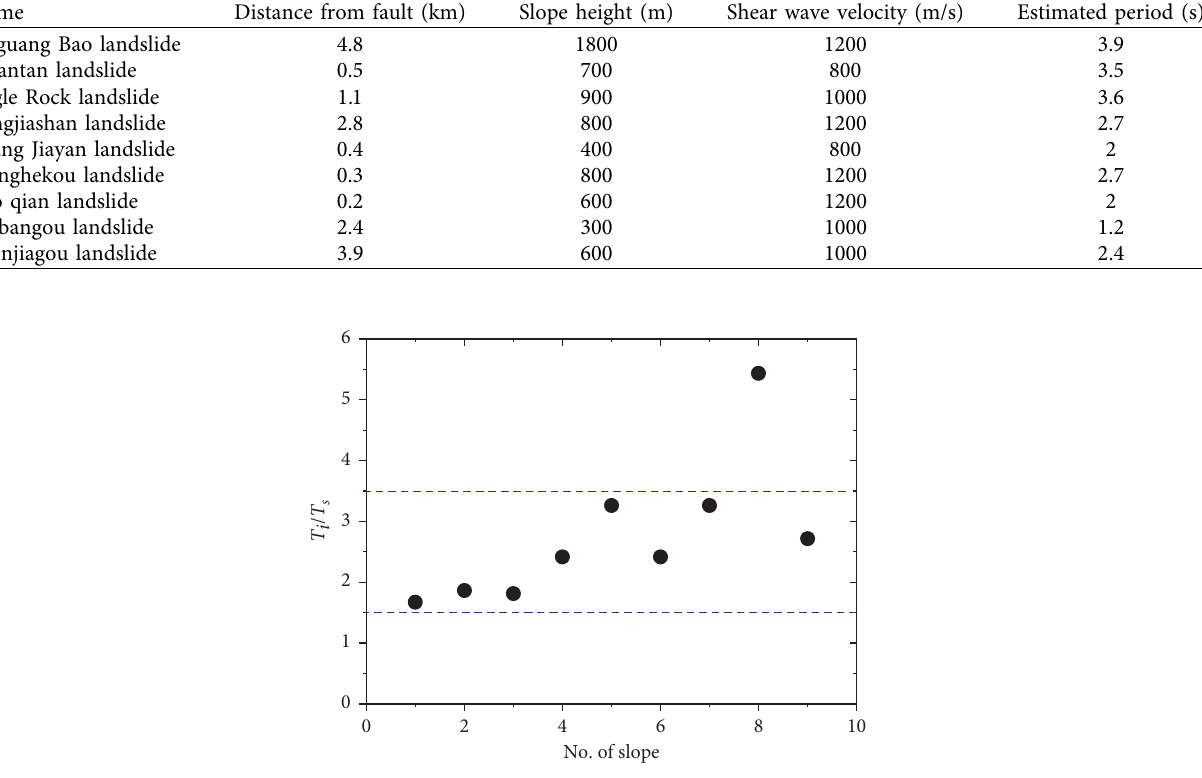
Figure 9: Ratio of the pulse-like ground motion period to the natural period of the large-scale landslide regarded as a homogeneous mass in Wenchuan